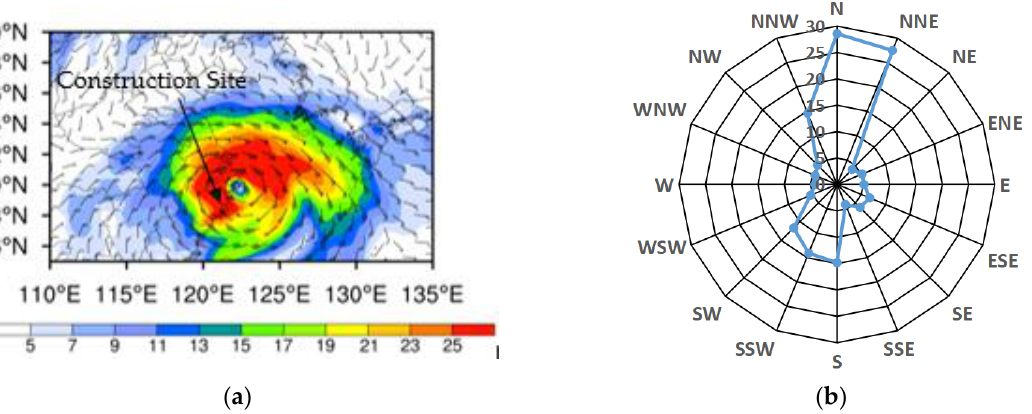
Figure 12. ( a ) Wind field map as the typhoon passed over the construction site; ( b ) wind rose diagram for the duration of the typhoon.